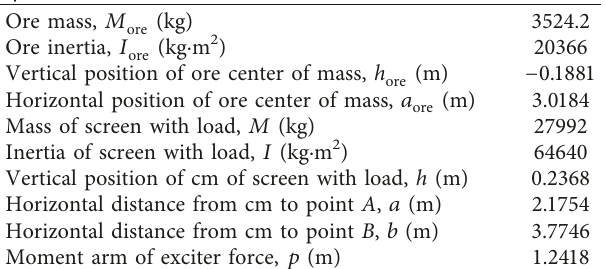
Table 4: Parameters of the ore obtained from DEM are used for dynamical simulations.